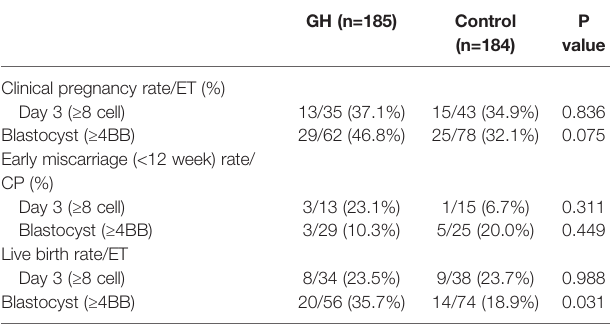
TABLE 7 | Clinical outcomes of frozen-thawed cycles strati fi ed by embryo